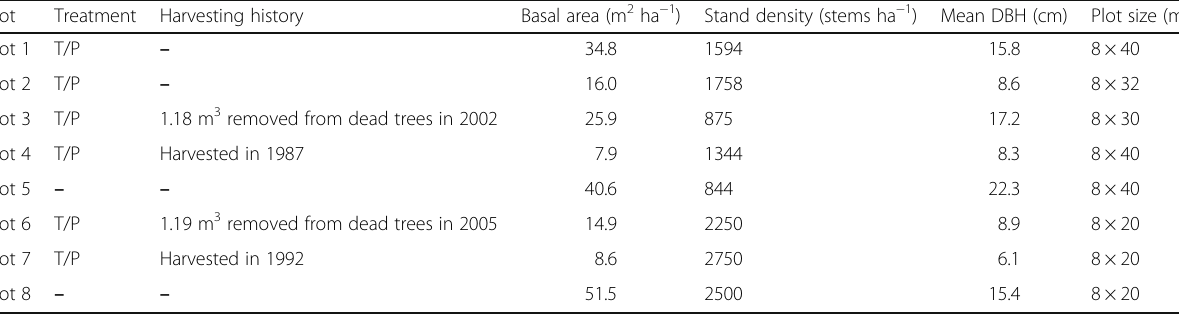
Table 1 Size, structure and silvicultural history of the eight permanent plots used for the analysis Plot Treatment Harvesting history